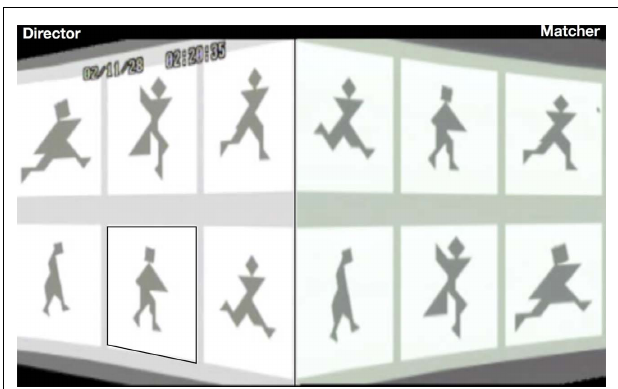
FIGURE 1 | Split screen view of an example tangram trial used in this task. The director, looking at the screen on the left, seeks a description to help the matcher select the same shape on his or her screen. Across rounds, referential language changes from detailed descriptions, such as “the guy kind of carrying the triangle,” (highlighted here with a box) to simplified, entrained expressions, such as “carrying